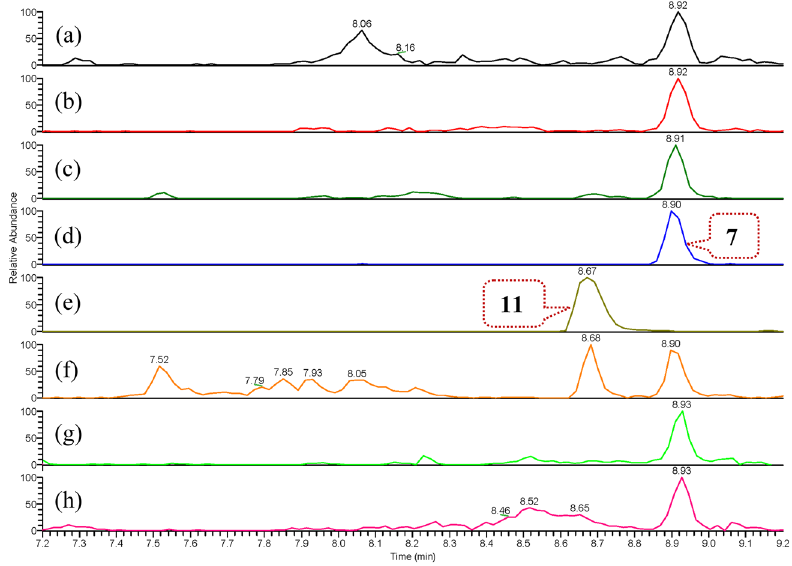
Fig. 5 Overlaid regional UPLC-HRESIMS chromatograms of extracted positive ion at m/z 521 [M + Na] + from (+)-TIC of: a